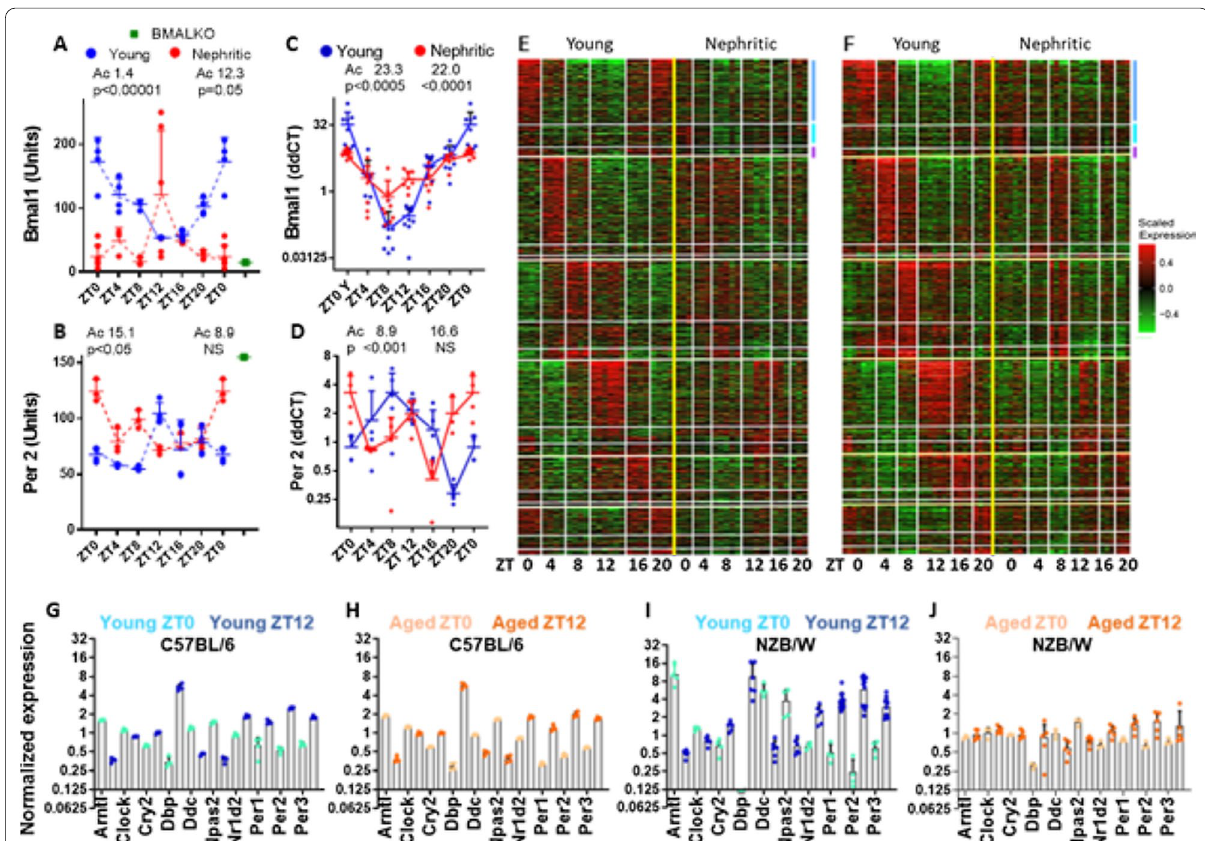
Fig. 1 A , B Bmal1 and Per2 protein expression measured in renal lysates by ELISA (shown in dashed lines); C , D Bmal1 and Per2 expression measured in whole renal mRNA by qPCR (shown in solid lines)—each symbol represents one mouse;); Ac time of acrophase, ZT Zeitgeiber time where ZT0 is the time of lights on. E Heatmap of all genes passing the RAIN test for circadian rhythm in young and nephritic kidneys. Complete results from the microarray analysis are on the left and from the RNASeq analysis are on the right. For each time interval, indicated by Zeitgeiber time (ZT0 lights on, ZT12 lights off), genes regulated in young mice are shown in the upper panel (blue bar), those regulated in nephritic mice = = are shown in the middle panel (aqua bar) and those regulated in common between the two groups are shown in the lower panel (purple bar). F – I RNASeq data of circadian transcriptional regulators in young (light and dark blue— F , H ) and old (light and dark orange— G , I ) C57BL/6 mice at ZT0 (light colors) and ZT12 (dark colors) F , G compared with young (light and dark blue) and nephritic (light and dark orange) NZB/W kidneys H , I —each symbol represents one